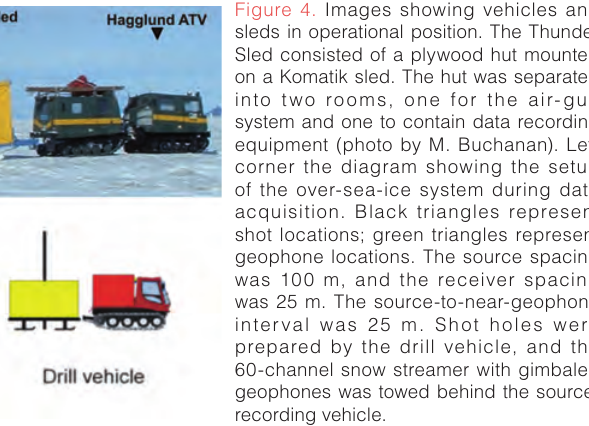
Figure 4. Images showing vehicles and sleds in operational position. The Thunder Sled consisted of a plywood hut mounted on a Komatik sled. The hut was separated into two rooms, one for the air-gun system and one to contain data recording equipment (photo by M. Buchanan). Left corner the diagram showing the setup of the over-sea-ice system during data acquisition. Black triangles represent shot locations; green triangles represent geophone locations. The source spacing was 100 m, and the receiver spacing was 25 m. The source-to-near-geophone interval was 25 m. Shot holes were prepared by the drill vehicle, and the 60-channel snow streamer with gimbaled geophones was towed behind the source/ recording vehicle.